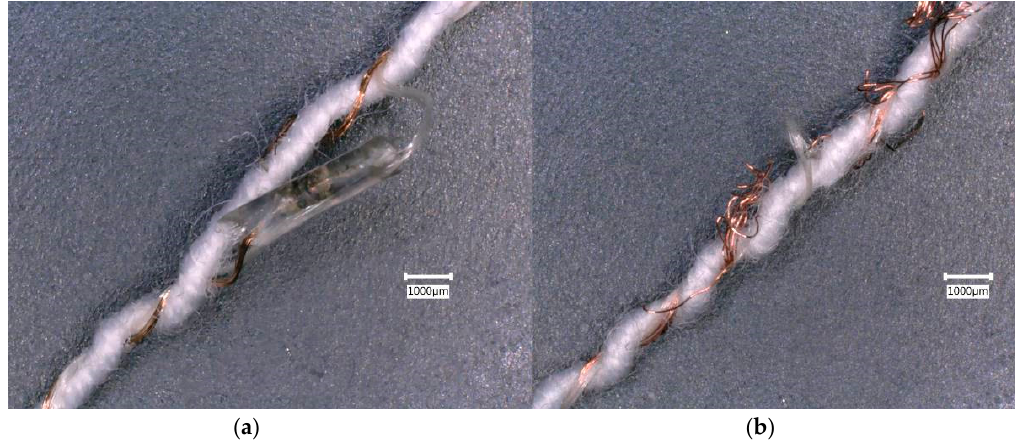
Figure 7. Thermistor yarns at 30X magnification: ( a ) Copper wire detached from the right side of the micro-pod; ( b ) Frayed wire greater than 50 mm away from a micro-pod.